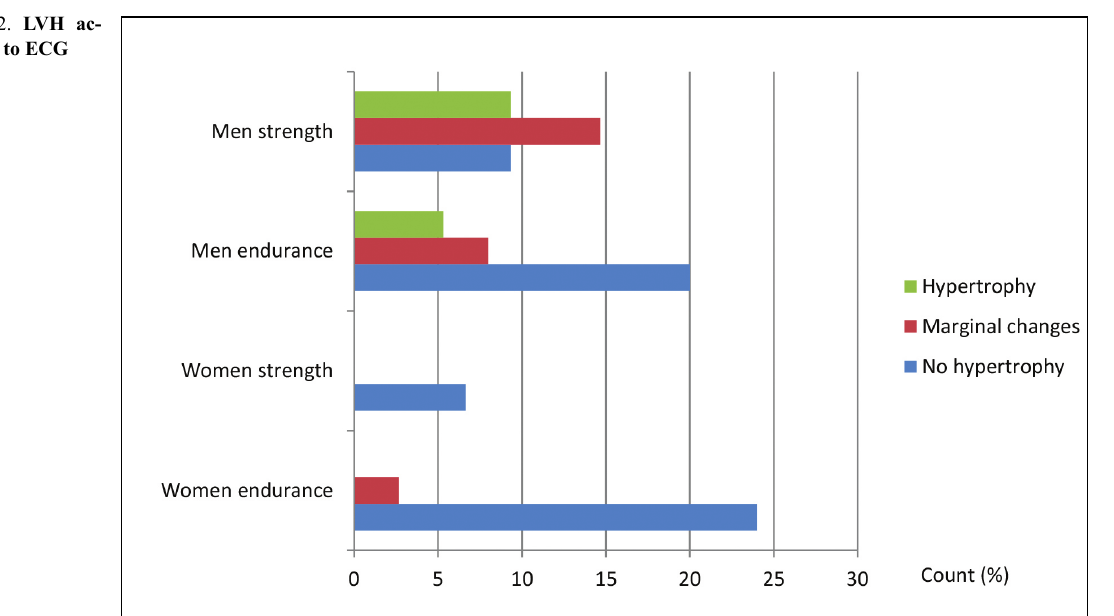
Figure 2. LVH ac - cording to ECG